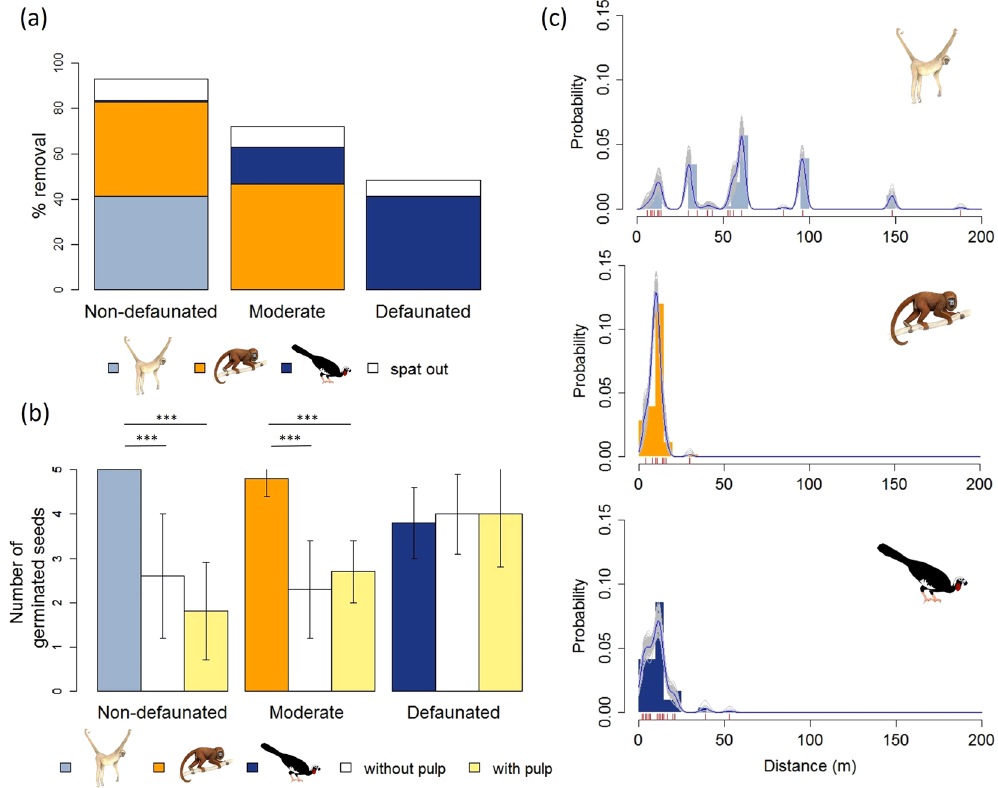
Figure 1. Components of seed dispersal effectiveness of the three main dispersers of C. mandioccana . ( a ) Percentage of seeds swallowed by muriquis, howler monkeys, and jacutingas, as well as the percentage of spat out seeds (all frugivore combined) in the three study sites characterized by different seed disperser communities: Non defaunated (muriquis, howler monkeys, and jacutingas), Moderate (howler monkeys and jacutingas), and Defaunated (jacutingas). Data are based on focal observations of C. mandioccana fruiting trees in 2011–2012 (Non-defaunated: N = 172 h; Moderate: N = 108 h, and Defaunated: N = 153 h). ( b ) Germination success of seeds defecated by muriquis, howler monkeys, and jacutingas, compared to seeds without pulp and seeds with pulp along the defaunation gradient. Bars represent the mean number of germinated seeds out of five seeds (ten replicates) and vertical lines represent standard deviation. ( c ) Seed dispersal distances to C. mandioccana conspecifics by muriquis (N = 173), howler monkeys (N = 127), and jacutingas (N = 168). Frequency distributions of seed dispersal distances (5 m-bins) where red vertical bars represent each observed dispersal event and the blue and grey lines, a non-parametric smoothing spline fit to the empirical distance distributions together with bootstrapped estimates. (Illustrations of: muriqui and howler monkey - Copyright Stephen D. Nash; jacutinga – Copyright Fabio Martins Labecca, authorized by the